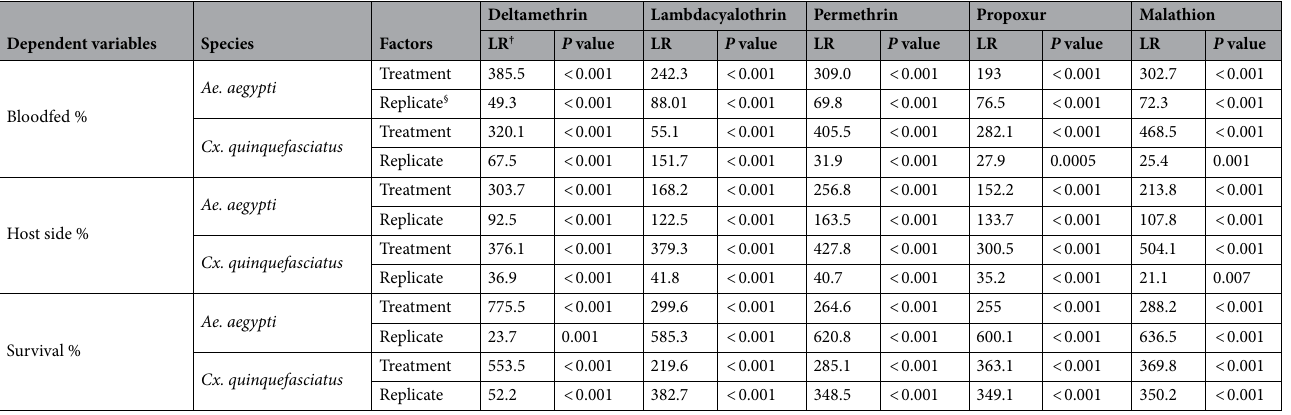
Table 1. Logistic regressions testing the effects of the 4 treatment groups and replicates on the proportion of females that bloodfed, survived and were found in the host section of the tunnel assay. All dependent variables